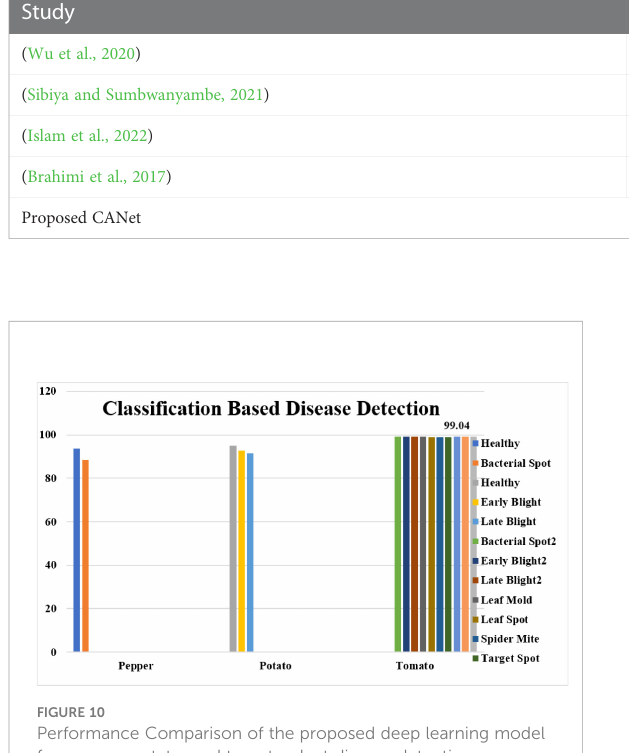
TABLE 12 Performance Comparison of the proposed disease subtype classi fi cation model with some state-of-the-art models.